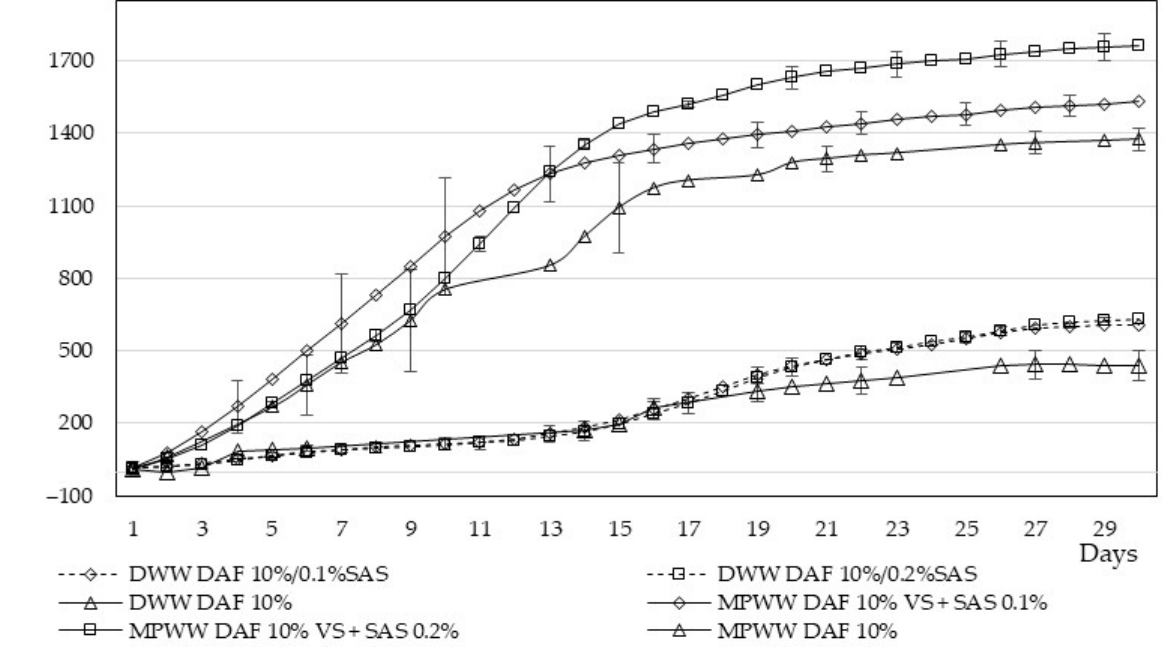
Figure 6. MPWW DAF sludge substrate and DWW DAF sludge substrate 30-day cumulative BMP value with anionic surfactant effect.